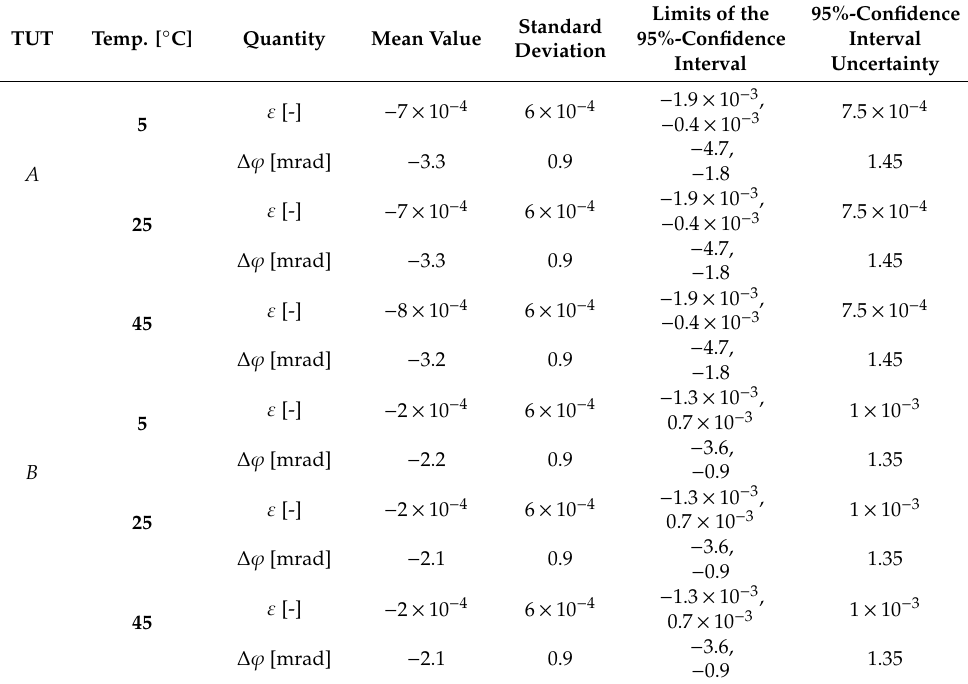
Table 5. Results of the Monte Carlo (MC) method application when considering the nominal accuracy specifications for the uncertainty